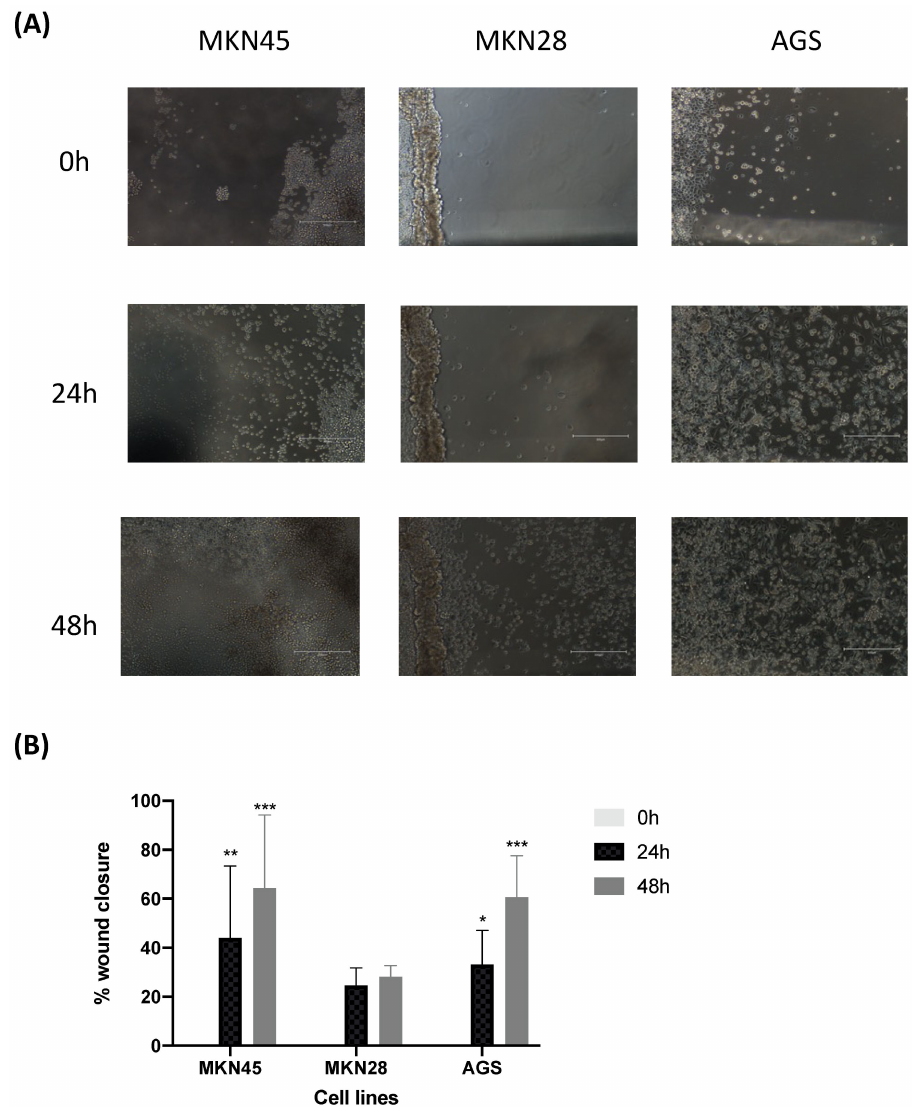
Figure 4. Results of MKN45, MKN28, and AGS cell lines by the wound healing assay. ( A ) Repre- sentative images of the different cell lines’ migration abilities with different time points (0 h, 24 h, and 48 h); ( B ) area quantification of the different cell lines in the different time points (0 h, 24 h, and 48 h). Values are expressed as percentages of control and represent means ± SEM. Each experiment was conducted three times independently ( n = 3); * statistically significant vs. control at p < 0.05. ** Statistically significant vs. control at p < 0.01. *** Statistically significant vs. control at p < 0.001; scale bars, 300 µ